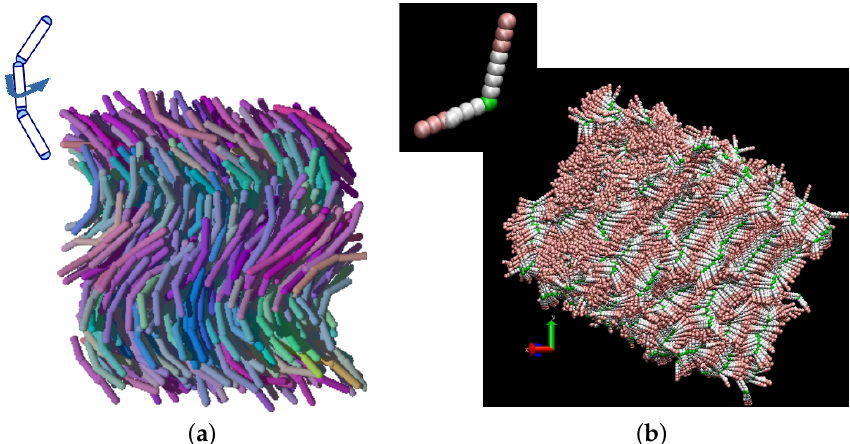
Figure 5. ( a ): Snapshot from a simulation of a simple coarse-grained simulation model of jointed spherocylinders. 1728 molecules are used with each molecule composed of three bonded sphero- cylinders interacting through the soft spherocylinder model of Lintuvuori and Wilson [23,58]. The angle between adjacent spherocylinders is set at 150 degrees. A torsional potential about the cen- tral spherocylinder is used to control the orientation of the two arms to impose an average planar conformation corresponding to a typical bent-core mesogen. The snapshot shows a N TB phase that arises spontaneously on cooling from a higher temperature nematic phase. ( b ): Twisted layer structures arising from simulations of 10,000 chiral-rigid-asymmetric-bent-core molecules. Green and white spheres represent a central aromatic core and interact through a Lennard–Jones potential with σ / σ 0 = 0.75, the pink spheres interact through a WCA potential with σ / σ 0 = 0.75. The two arms are positioned at an angle of 120